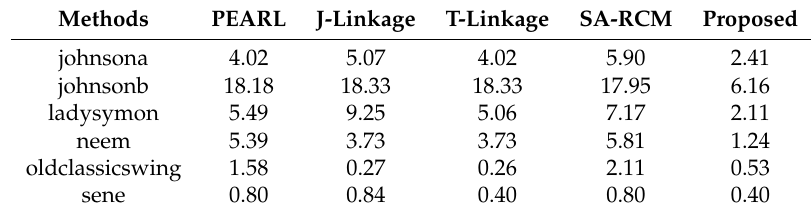
Table 1. Misclassification (%) for the multi-homography estimation.